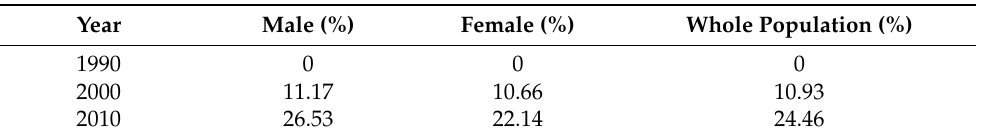
Table 9. Percentage of migrant workers in the male population, female population, and the whole population in Sanjiang